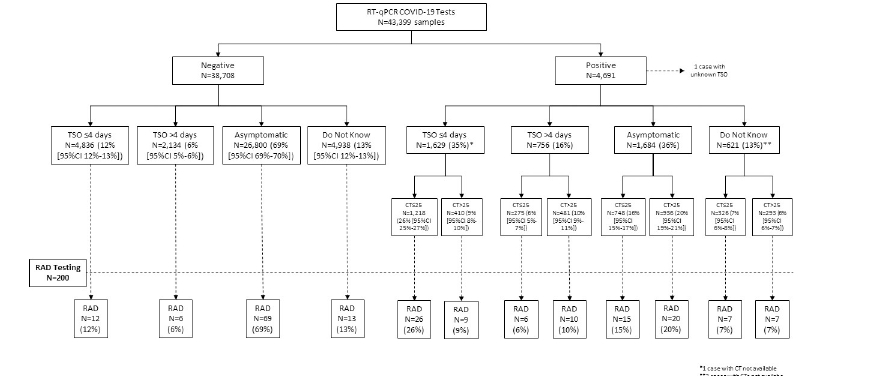
Fig 1. Study flowchart. TSO, time from symptoms onset; RAD, rapid antigen detection.